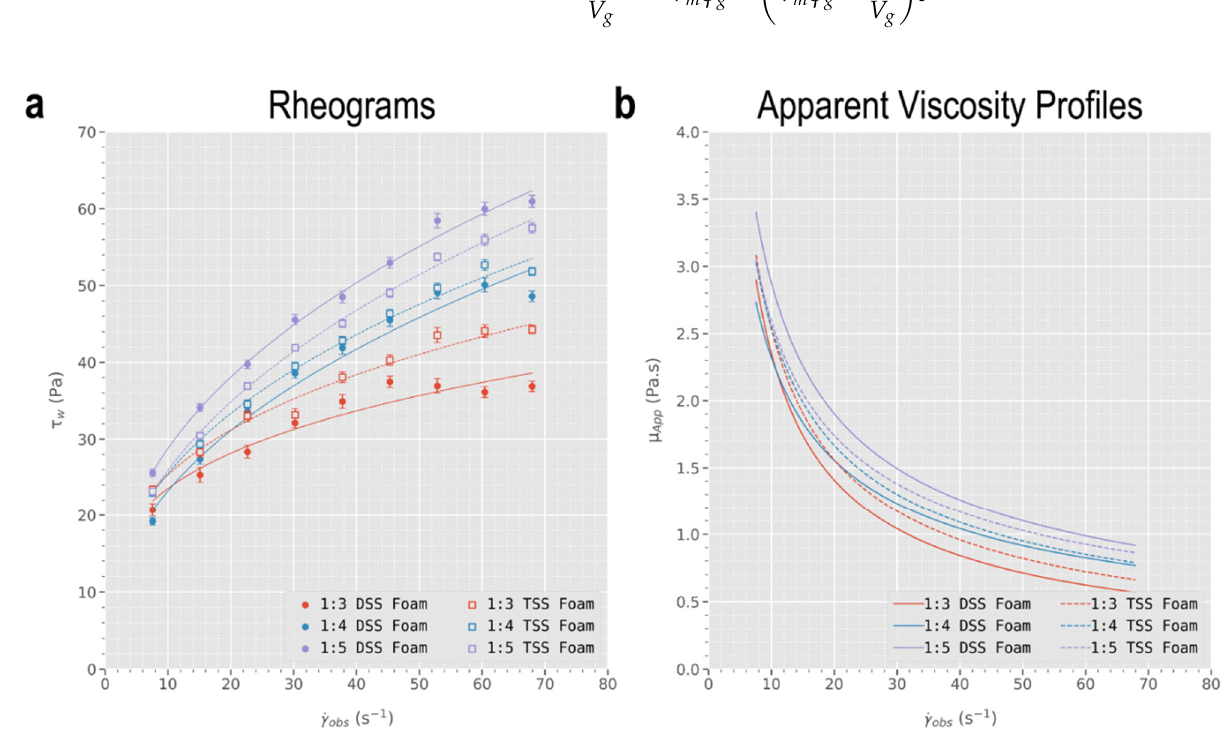
Figure 3. ( a ) Rheograms with non-linear power-law fits and ( b ) apparent viscosity profiles of DSS and TSS foams. The decreasing slopes of the rheograms and the declining trendlines of apparent viscosity indicate a shear-thinning behaviour of the foams. It is also evident that increasing gas fraction leads to an increase in apparent viscosity.